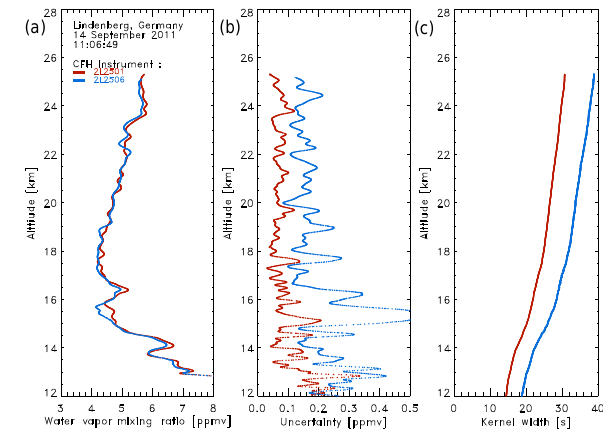
Figure 2. Water vapor profile launched at Lindenberg, showing a pronounced vertical feature, which is again detected on descent. Left panel: raw data at 1s resolution. Right panel: ascent and de- scent data time lag, corrected using a 10s time lag constant.